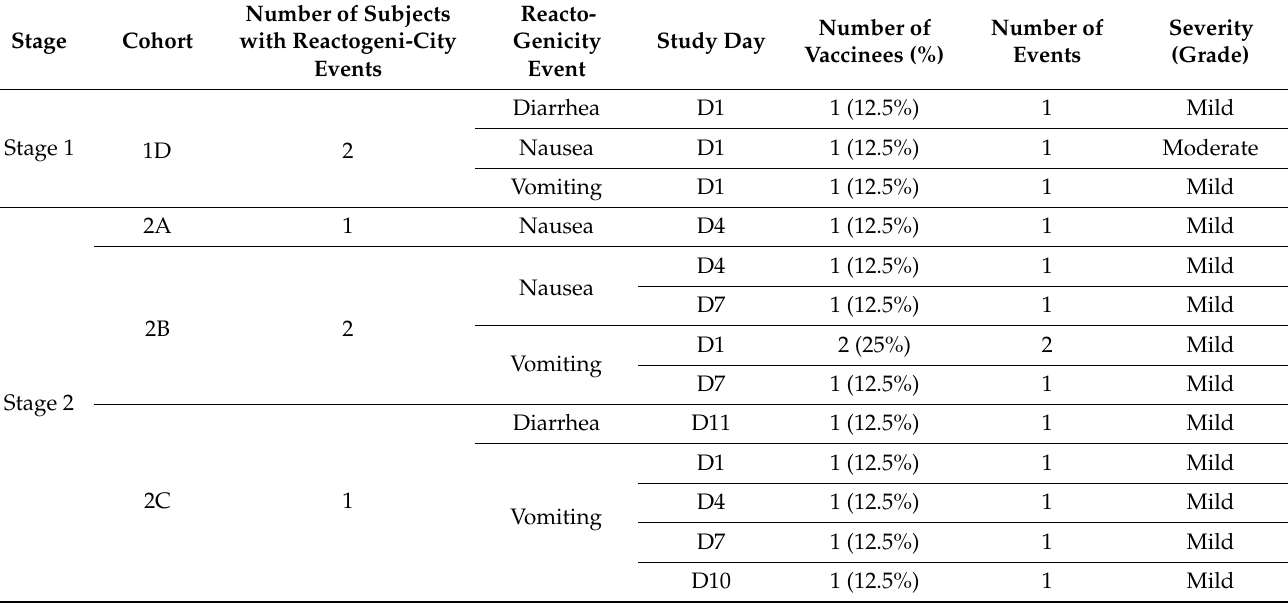
Table 2. Reported reactogenicity events in vaccine